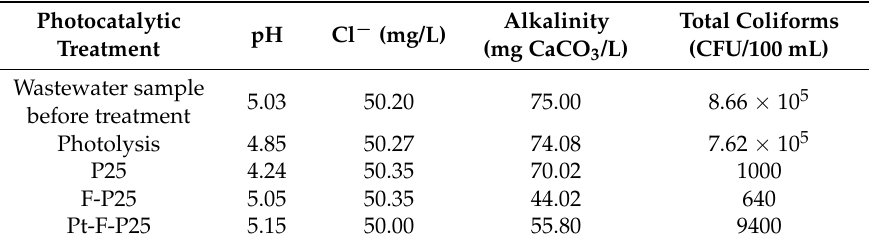
Table 3. Average results of the physicochemical and microbiological analysis for wastewater samples coming from handicrafts factories, before and after 5 h of photocatalytic